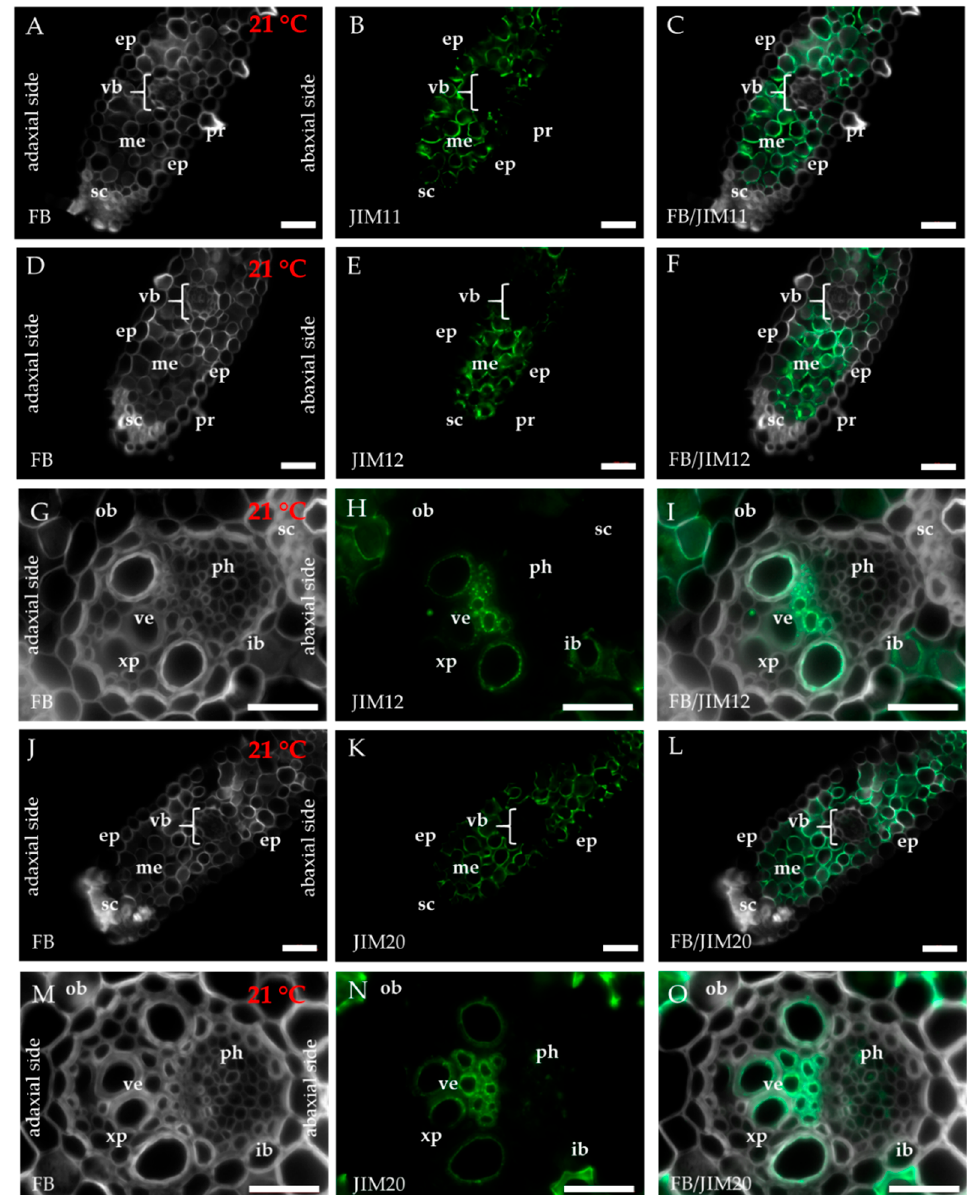
Figure A5. Immunolocalisation of the JIM11 ( A – I ), JIM12 ( D – I ) and JIM20 ( J – O ) epitopes in cross ‐ sections of B. distachyon leaves (21 °C), ( A – F , J – L ): through the edge of the leaf blade; ( G – I , M – O ): through the major vascular bundle. Abbreviations: bc—bulliform cells, ep—epidermis, FB—fluorescent brightener, ib—inner bundle sheath, me—mesophyll, ob—outer bundle sheath, p— phloem, pr—prickle, sc—sclerenchyma, vb—vascular bundle, ve—vessels, xp—xylem parenchyma. The green colour shows epitope occurrence. Scale bars: 20 μ m. Table A1. The oligonucleotide primers that were used for the RT ‐ qPCR reaction with relevant descriptions of the genes. Genes